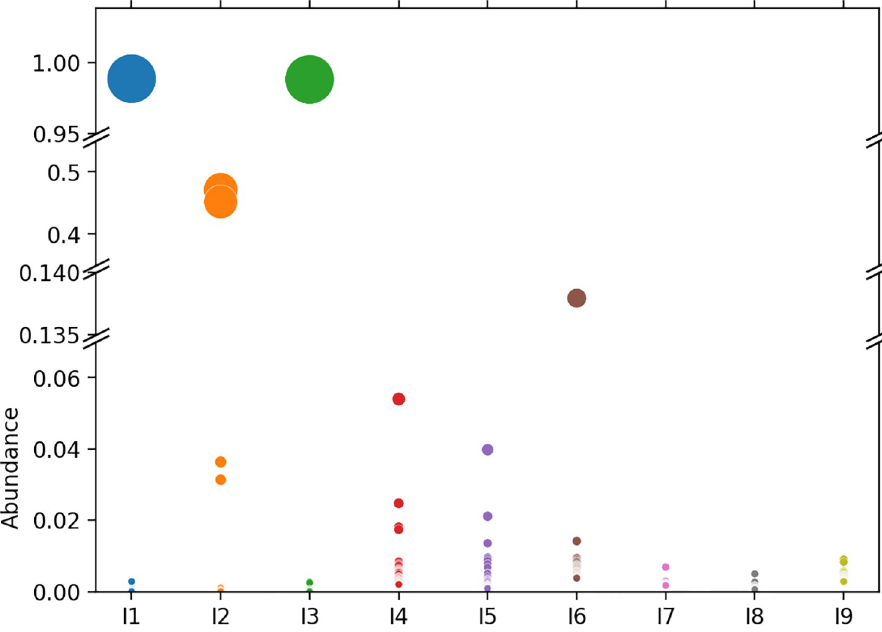
Fig 11. Clonal distribution/density of nine experimental repertoires. We plotted the 20 most abundant clonal lineages for each repertoire; Circles represent clonal groups, while their areas are proportional to the clonal group